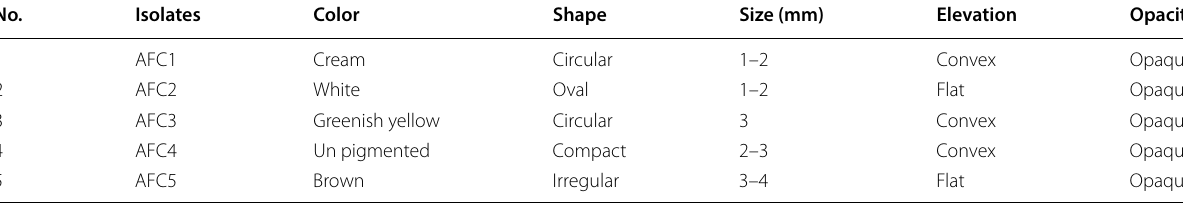
Table 1 Colony morphology of the bacteria isolated from termite gut contents No.